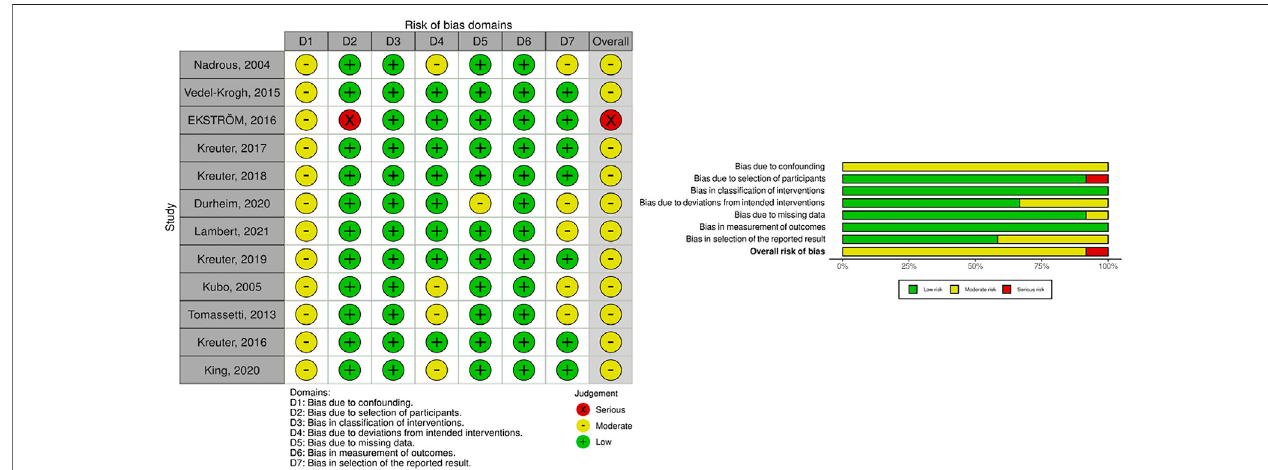
FIGURE 2 | Risk of bias graph.